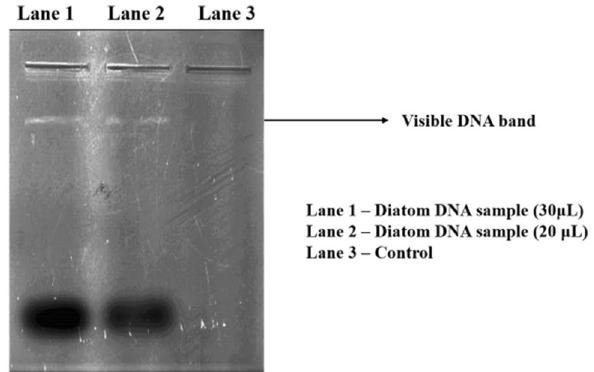
Figure 4. Agarose gel showing isolated genomic DNA of Nitzschia palea in Lane 1 and 2.